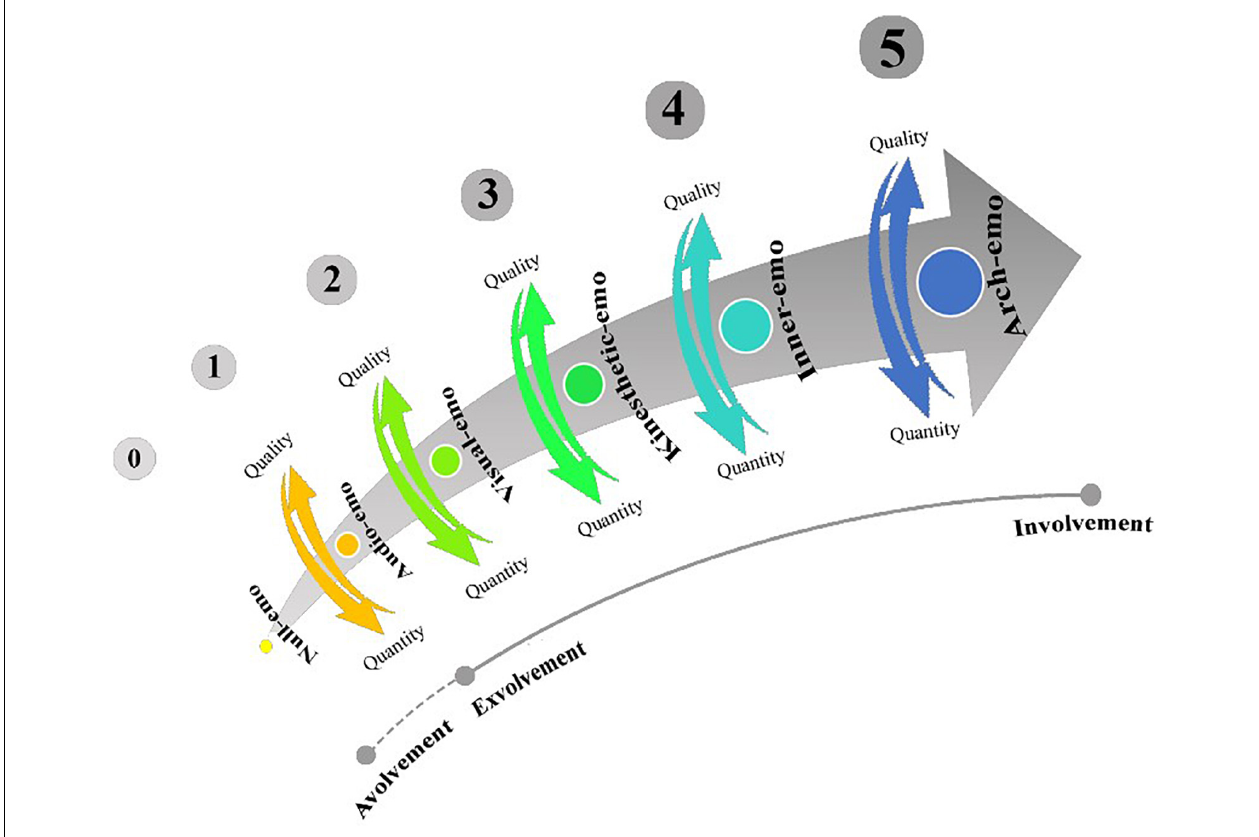
FIGURE 1 | Emotioncy levels [reprinted with permission from “Emotioncy, extraversion, and anxiety in willingness to communicate in English,” by Pishghadam (2016), Proceedings of the 5th International Conference on Language, Education, and Innovation. London, United